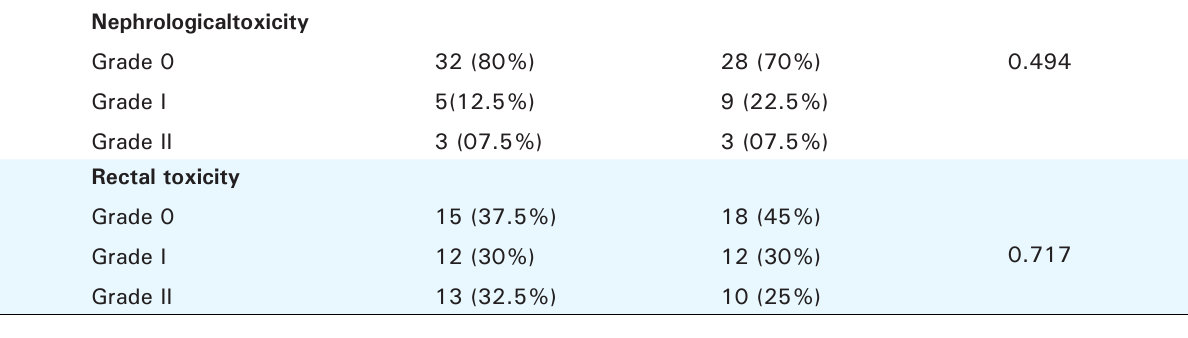
Table 4. Neutropenia, thrombocytopenia and neurotoxicity observed during treatment.